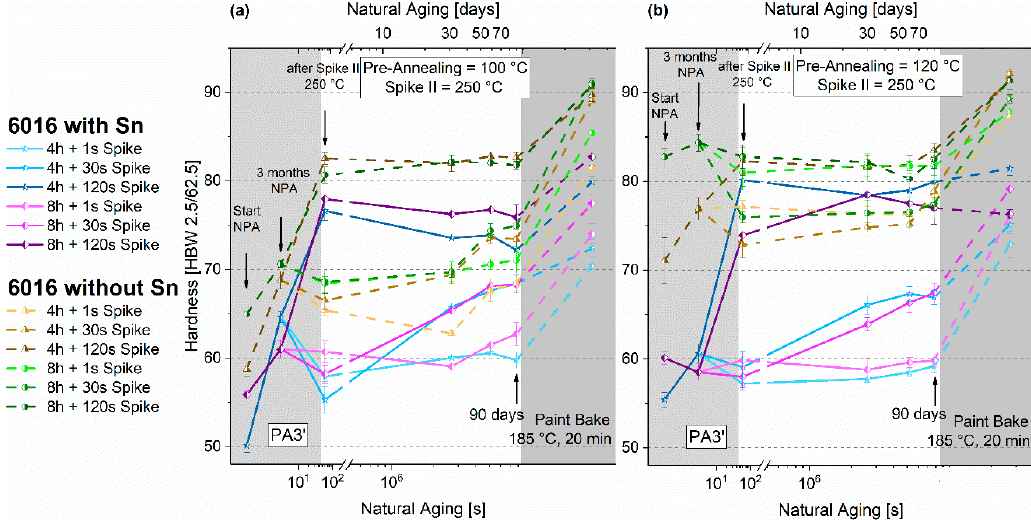
Figure 11. Natural aging behavior and paint-bake response of samples treated according to PA3’ for EN-AW-6016 Sn-free and EN-AW-6016 + 100 at.-ppm Sn. PA at 100 °C + Spike II 250 °C ( a ) and PA at 120 °C + Spike II 250 °C ( b ). The shaded areas depict the hardness behavior before application of Spike II. The shaded areas show the hardness evolution during the paint-bake treatment (185 °C, 20 min, no pre-deformation).